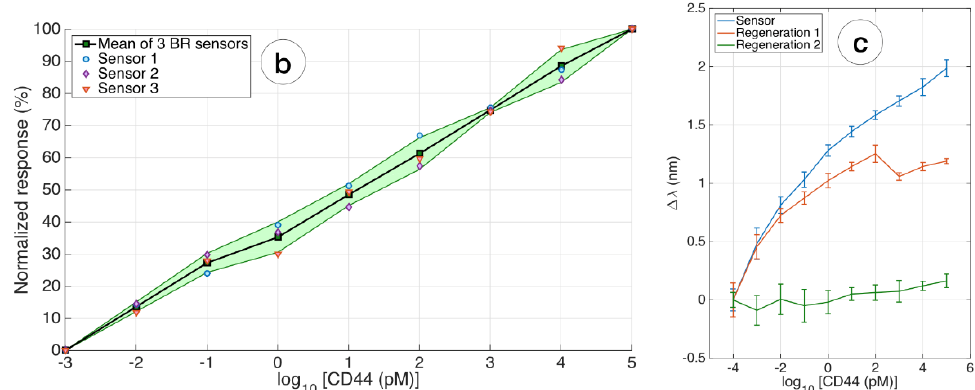
Figure 6. Evaluation of specificity, repeatability, and regeneration of the biosensor: ( a ) the specificity was estimated by comparing the response of the CD44 biosensor from the reference value, for every concentration within 1 fM and 10 nM, to two additional ball resonator sensors fabricated with the same method and having a similar sensitivity and interrogation process. Negative control = biosensor with no antibodies; PSA control = CD44-biosensor detecting different contrations of PSA. Error bars = ± standard deviation reported over 11 consecutive measurements; ( b ) repeatability of the whole biosensing device; the chart compares the normalized response, in terms of intensity change, for 3 different ball resonator biosensors fabricated and interrogated with the same method, responding to CD44 concentrations. Furthermore, 0–100% normalized values account for the response of the sensor at 1 fM ( ≈ LoD) and 100 nM, respectively. Solid line = average, shadowed region = ± standard deviation for 3 different sensors with same biofunctionalization; markers show individual data points; ( c ) regeneration of the biosensor: the chart displays the response of the same biosensor in the first measurement, compared with the sensor regenerated once (red) and twice